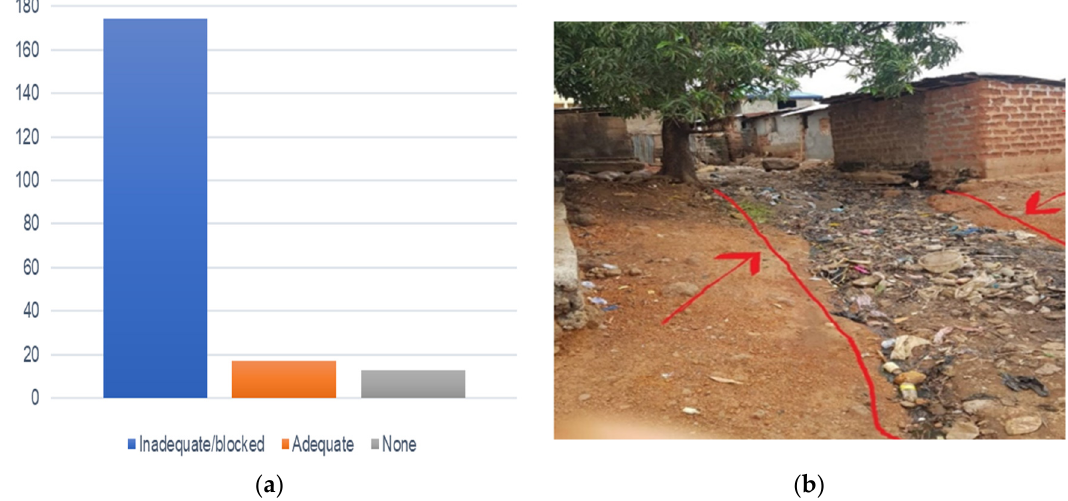
Figure 6. The condition/ availability of households’ drainage systems ( a ). A blocked channel that is supposed to drain overflows from households. ( b ) Source: Fieldwork.